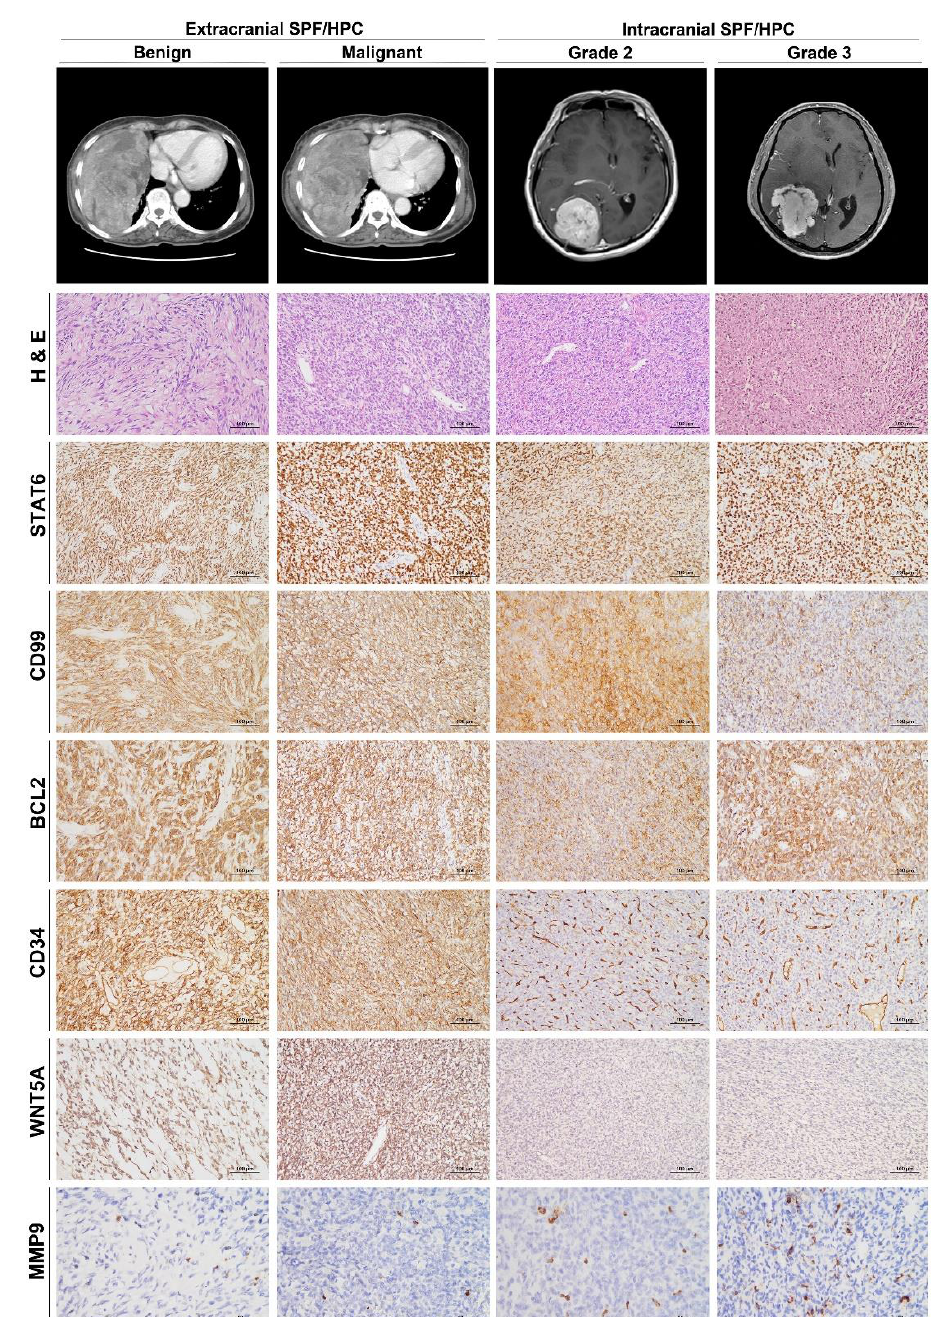
Figure 2. Representative images and histofigures of ic SFT/HPC and ex SFT/HPC. From top to bottom, chest computed tomography (CT), brain magnetic resonance imaging, Hematoxylin and Eosin (H&E) staining, and immunohistochemical staining for STAT6, CD99, BCL2, CD34, WNT5A, and MMP9 (original magnification: 200 × for H&E, STAT6, CD99, BCL2, CD34, and WNT5A; and 400 × for MMP9). From left to right, benign and malignant ex SFT/HPCs were followed by grade 2 and 3 ic SFT/HPCs. After a review of H&E slides, SFT/HPC cases were confirmatively selected by nuclear immunoreactivity of STAT6. Compared to the similar expression of CD99 and BCL2 across grades and locations, the CD34 immunostaining intensity was weaker in ic SFT/HPC than in ex SFT/HPC. Expression of WNT5A was also lower in ic SFT/HPC than ex SFT/HPC, but expression of MMP9 in occasional tumor cells was enhanced in ex SFT/HPC compared to ic SFT/HPC.